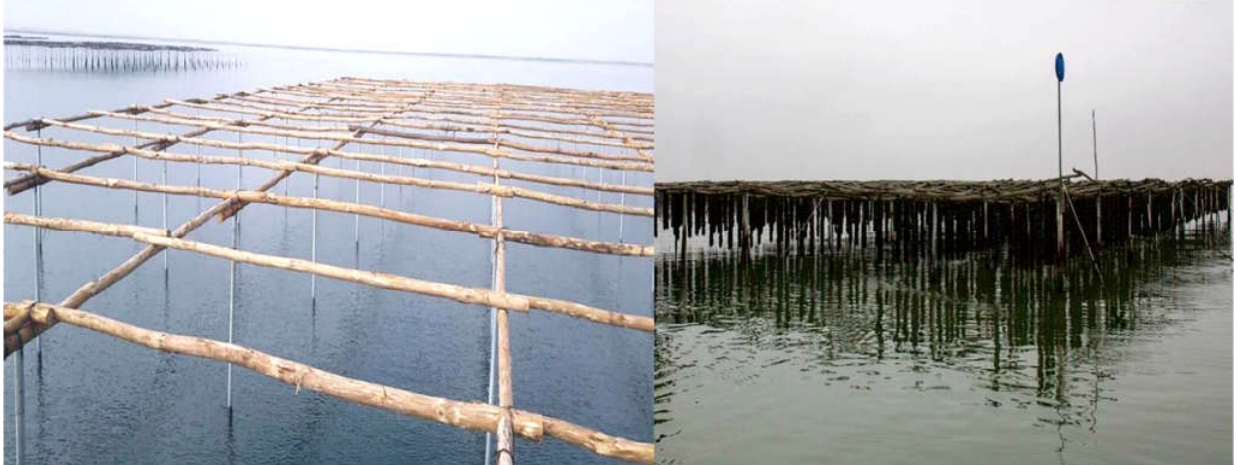
Figure 1. The hanging park bouchot type traditional technique applied in mussel farming in Axios River Delta (Kymina, Thermaikos Gulf, north Greece).